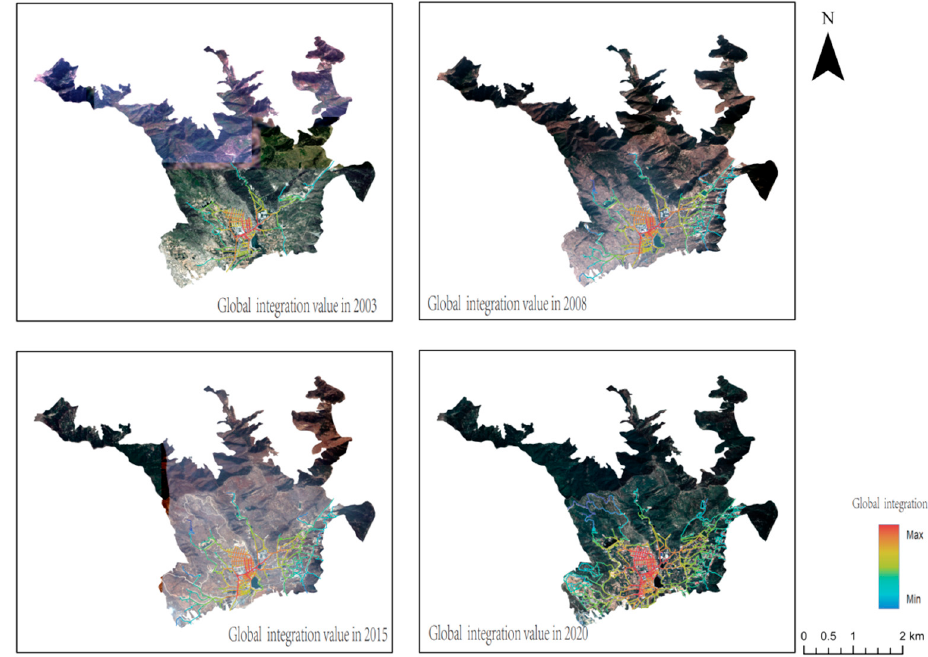
Figure 4. Evolution process of spatial global Integration Value in Matao Village.